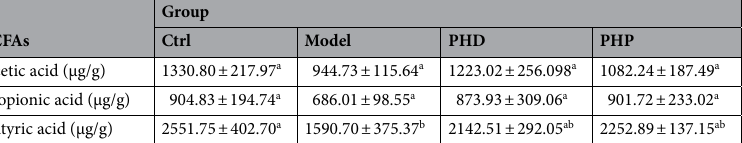
Table 5. Effect of PHD and PHP on the short chain fatty acids (SCFAs) in the cecal contents of rats. Data are expressed as mean ± SD (n = 5). Different lowercase letters (a, b and c) were significantly different at the level of p < 0.05.